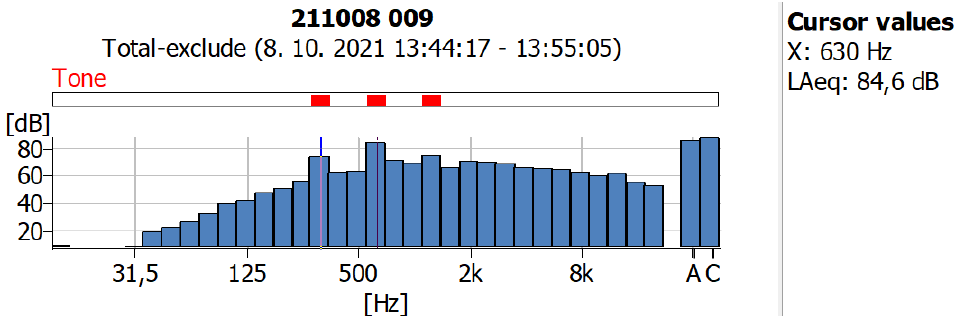
Figure 6. FFT analysis for 20,000 revolutions, feed speed 8 m.min −1 , and radial depth of cut 8 mm. The tone components are 315 Hz, 630 Hz, and 1,250 Hz, and the SPL (A) value at 630 Hz is 84.6 dB (processed using Measurement Partner Suite software – Brüel & Kjær, Denmark).